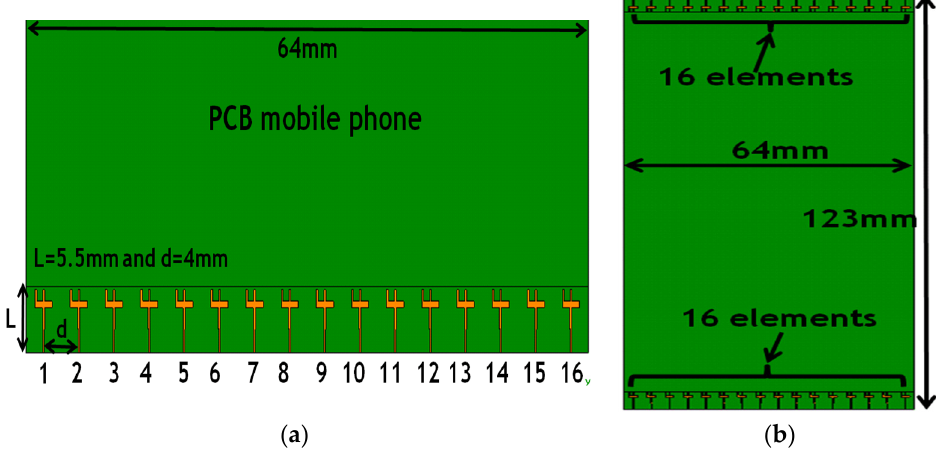
Figure 7. The geometry of the array antenna: ( a ) bottom portion of the PCB and ( b ) top view.